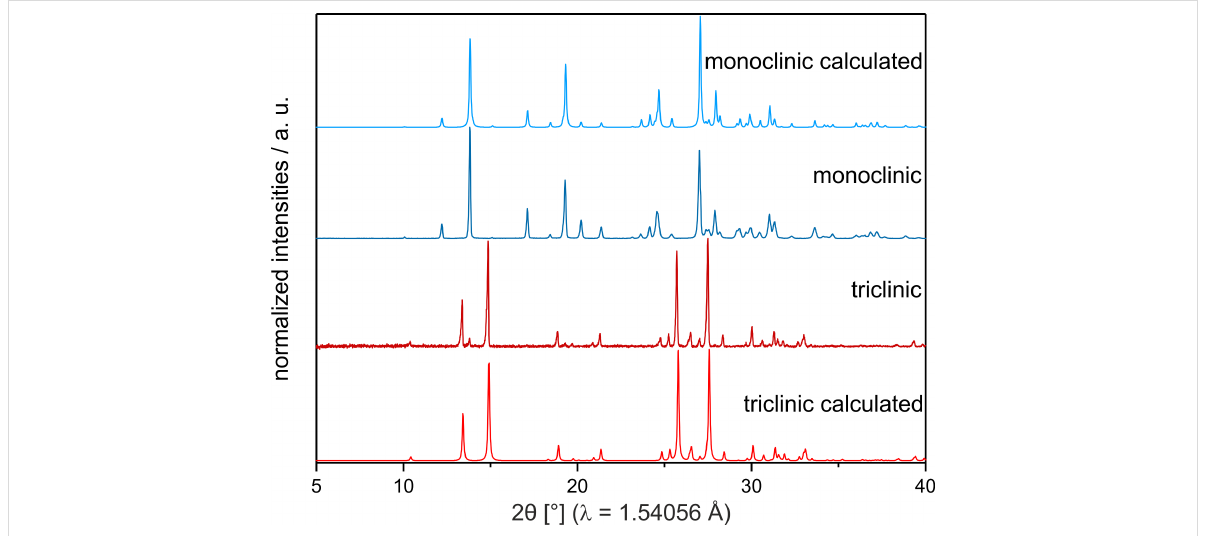
Figure 5: Comparison of XRPD patterns of both polymorphs of the product 3a . Red: triclinic polymorph t3a . Blue: monoclinic polymorph m3a . The light XRPD pattern were calculated from single crystal diffraction data.